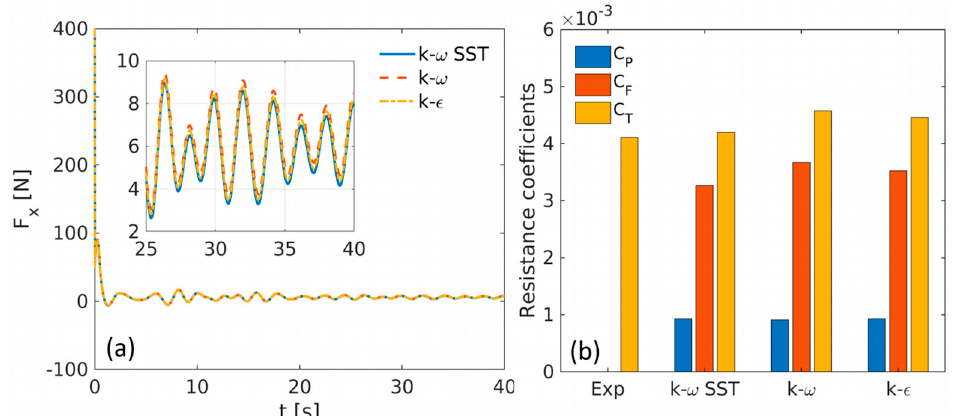
Figure 1. ( a ) Convergence histories of the drag ( F x ) and ( b ) comparison of resistance coefficients with different turbulence models of a KVLCC2 model. C T , C F , C P are the total, frictional and pressure resistance coefficients, respectively. The experimental data can be found in [28].